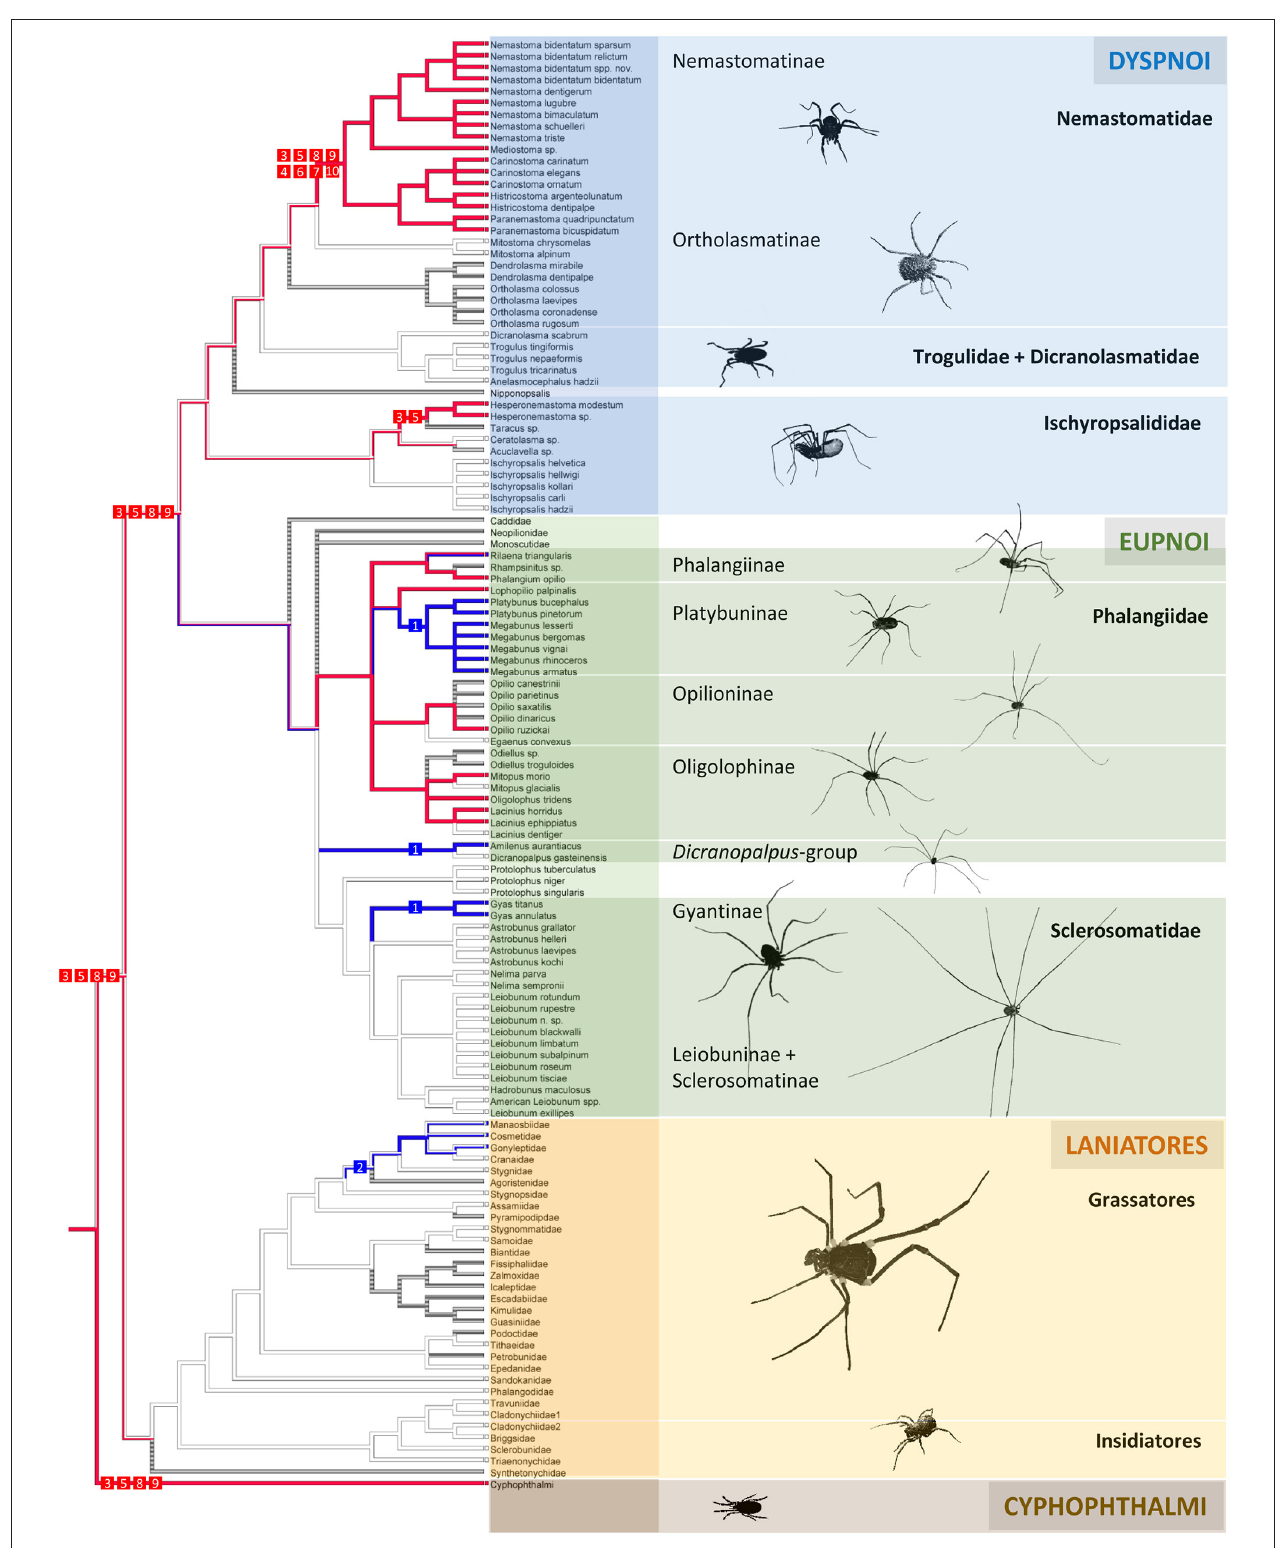
FIGURE 3 | Evolutionary history of naphthoquinones (red) and benzoquinones (blue) in the scent glands of Opiliones as evidenced by ancestral character state reconstruction (ASR). Numbers 1–11 ( = chemical characters) refer to compounds from Figure 1 . ASR was based on a maximum parsimony reconstruction of